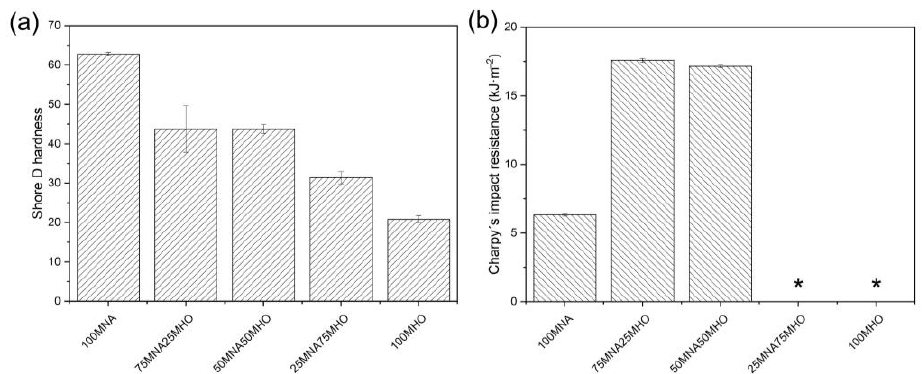
Figure 10. Results of impact and hardness tests on epoxidized hemp oil (MHO) crosslinking with different percentages of maleinized hemp oil and methyl nadic anhydride (MNA). ( a ) Shore D hardness and ( b ) Charpy ’ s resistance impact. * Unbroken samples.